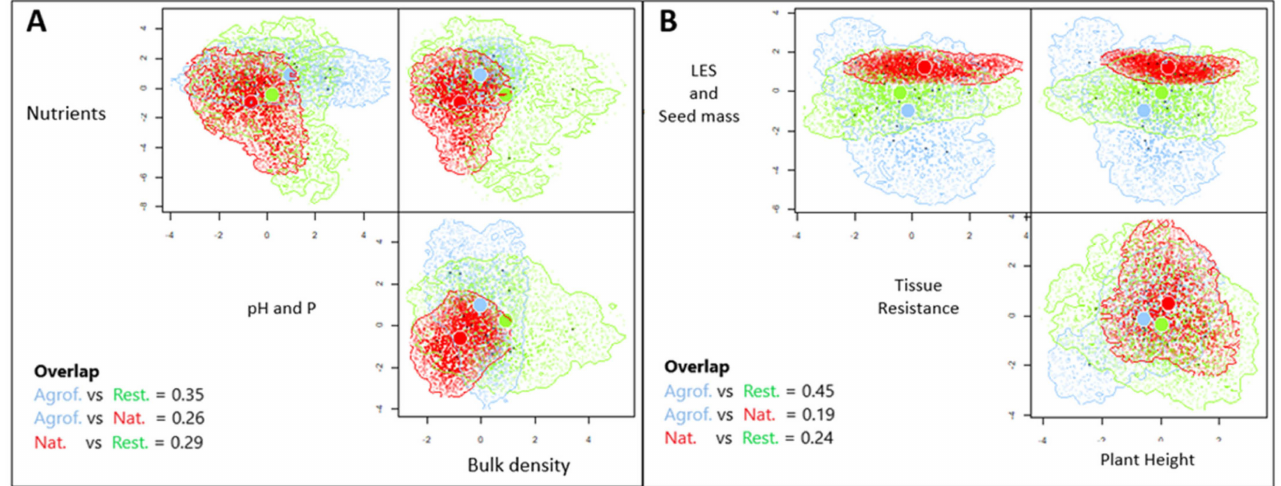
Figure 3. Estimated three-dimensional hypervolumes for the three ecosystem types (see Table 2). Each plant dimension was based on the first PCA axis of the different attributes belonging to soil properties ( A ) and functional trait ( B ) dimensions. Overlap among each type of ecosystem based on the Sørensen similarity index is